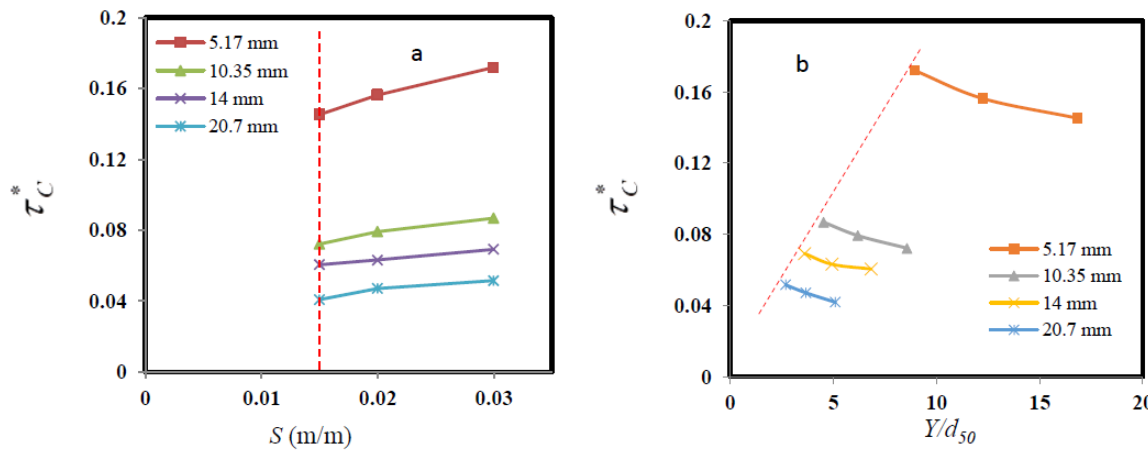
Figure 5. Critical Shields stress as a function of bed slope ( a ) and relative submergence ( b ) for each fraction in graded sediment.